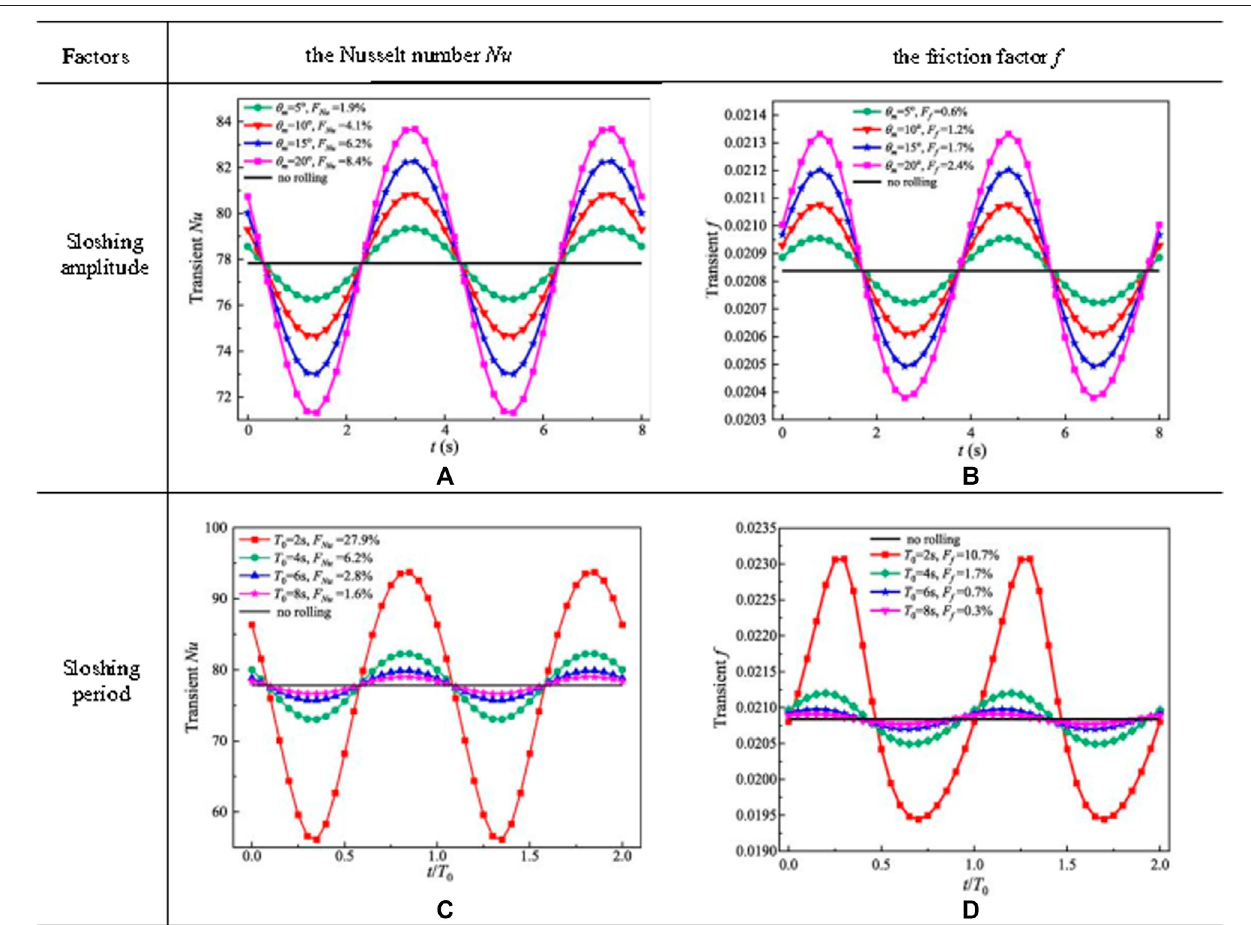
FIGURE 6 | Effect of sloshing conditions on thermal and hydraulic performance (Chen et al., 2022).